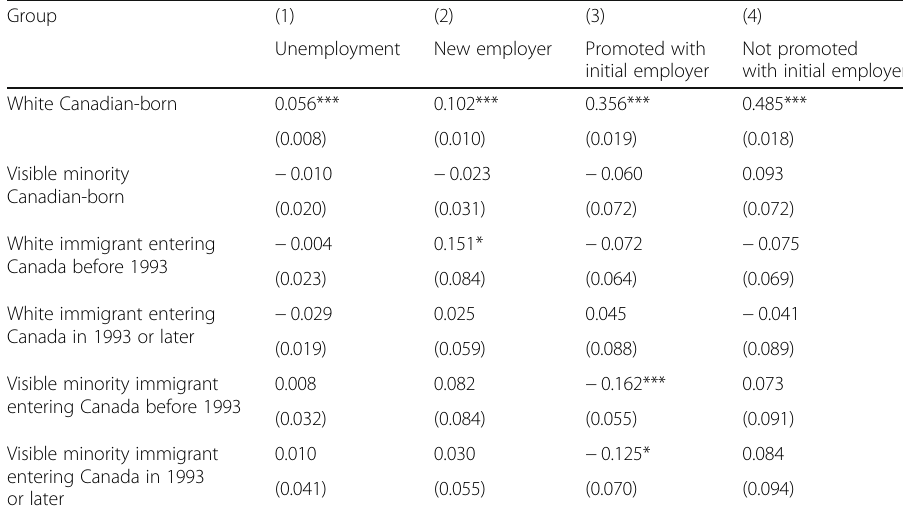
Table 4 Transition probabilities by year of